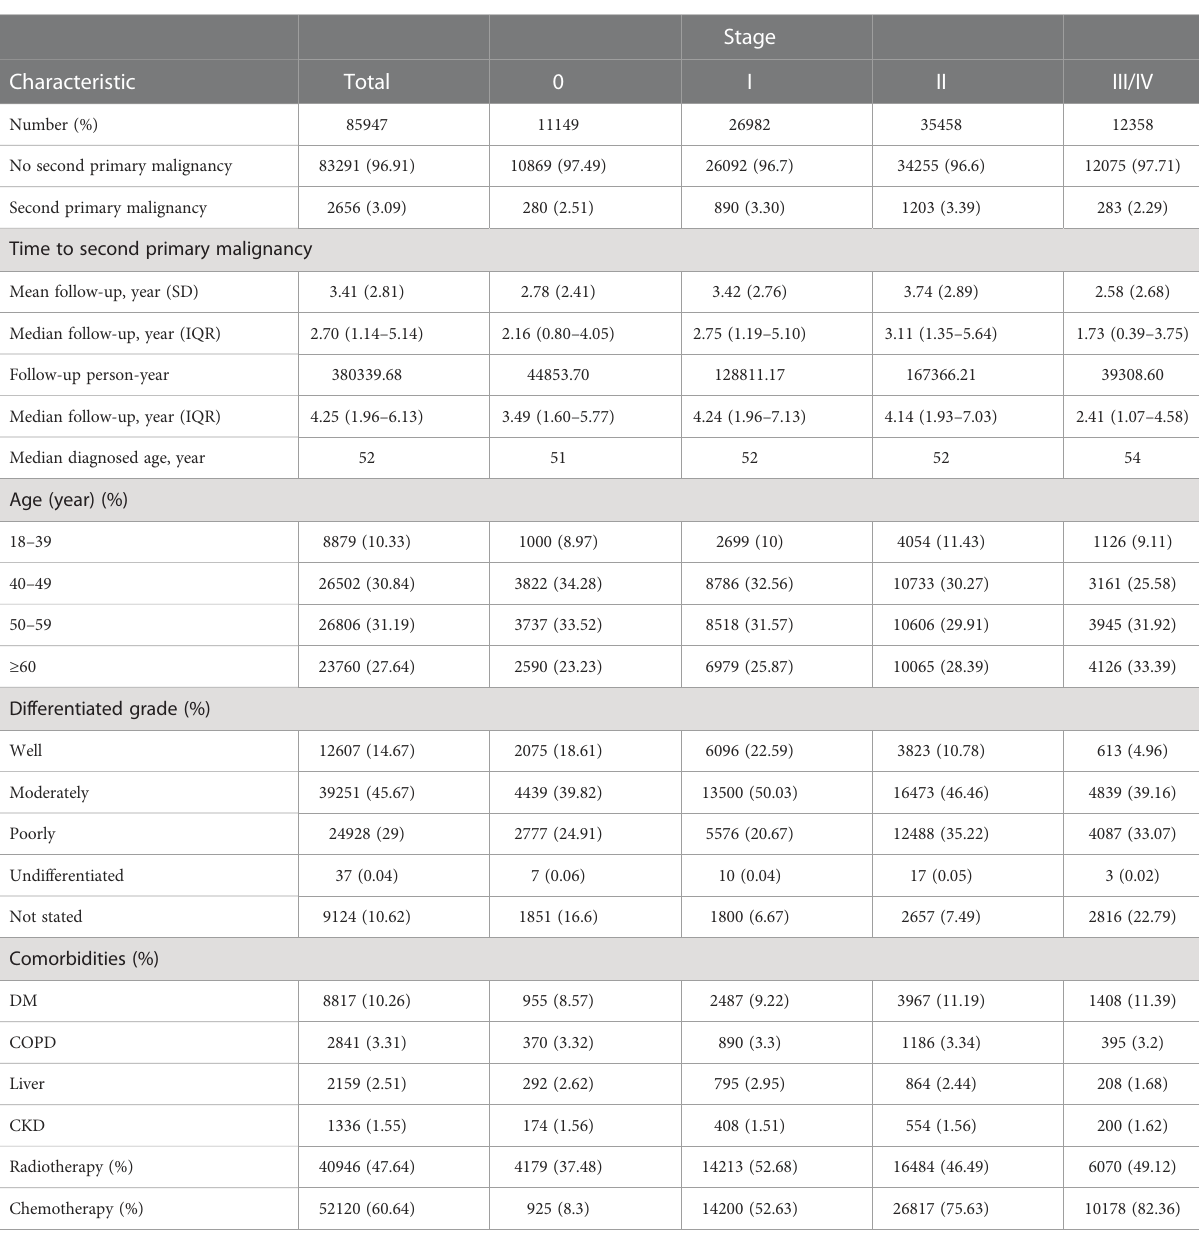
TABLE 1 Baseline characteristics of patients with breast